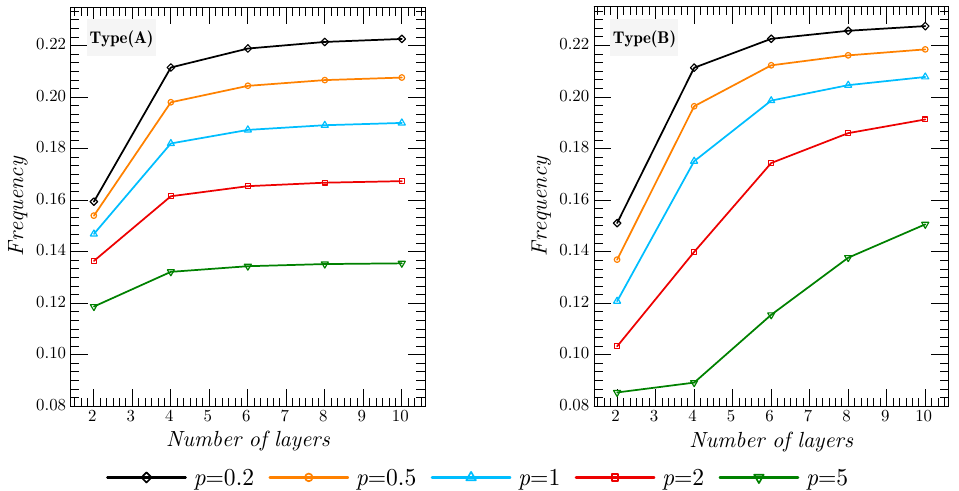
Figure 6. Effect of number of layers N and power-law index p on the dimensionless frequencies of CNTRC plates ( FG − X , SSSS , V ∗ cnt = 0.17, T = 300 K ) . High temperature reduces the stiffness of the structure by affecting the material prop- erties. Figure 7 presents an examination of the impact of the thermal environment on the vibrational response of the two types of simply supported spherical CNTRC shell for var- ious CNT distribution patterns. Because of the even distribution of CNTs in each layer (10 layers) of CNTRC(A) structures, we obtained similar results, and, therefore, we conclude that the CNT distribution pattern has almost no influence on the mechanical response, unlike the CNTRC(B) shell. In addition, increase in the temperature leads to a decrement in the rigidity of the CNTRC shell, and thus, the dimensionless frequency decreases.